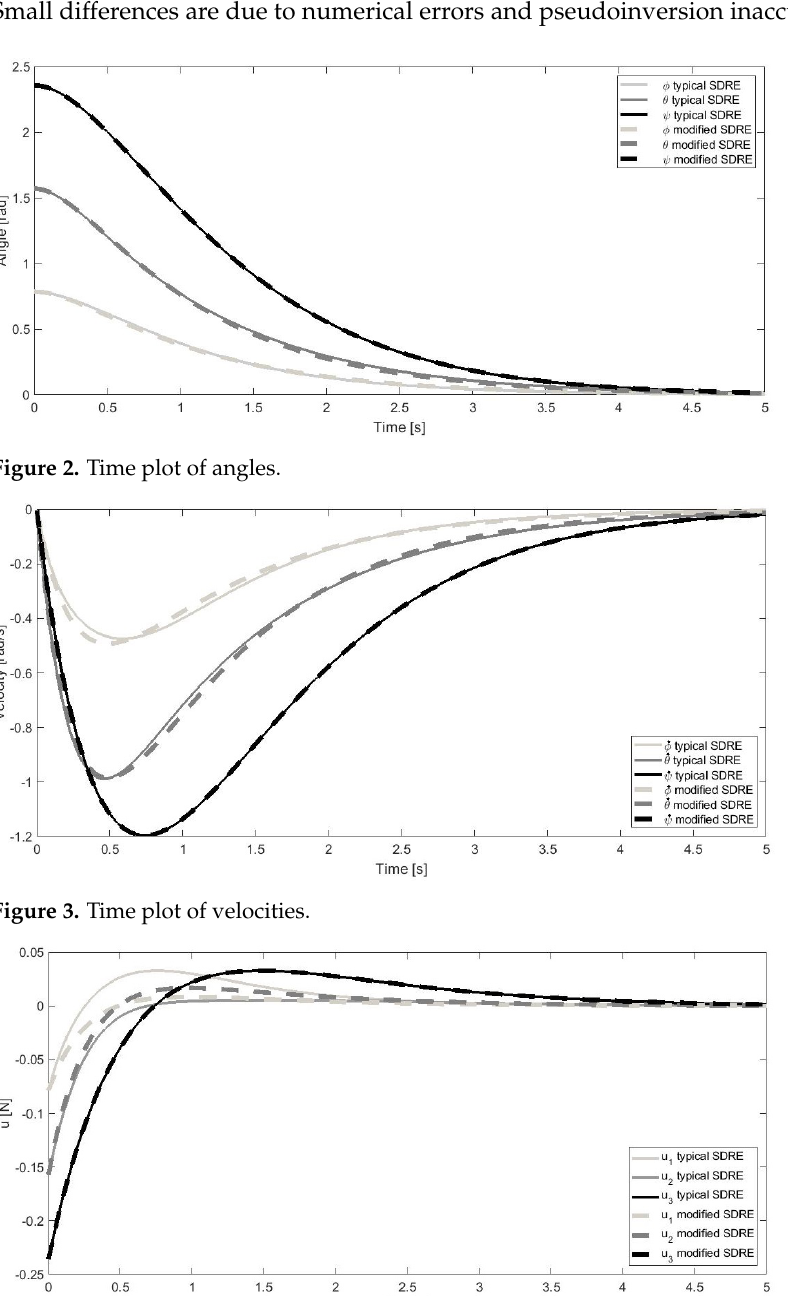
Figure 4. Time plot of